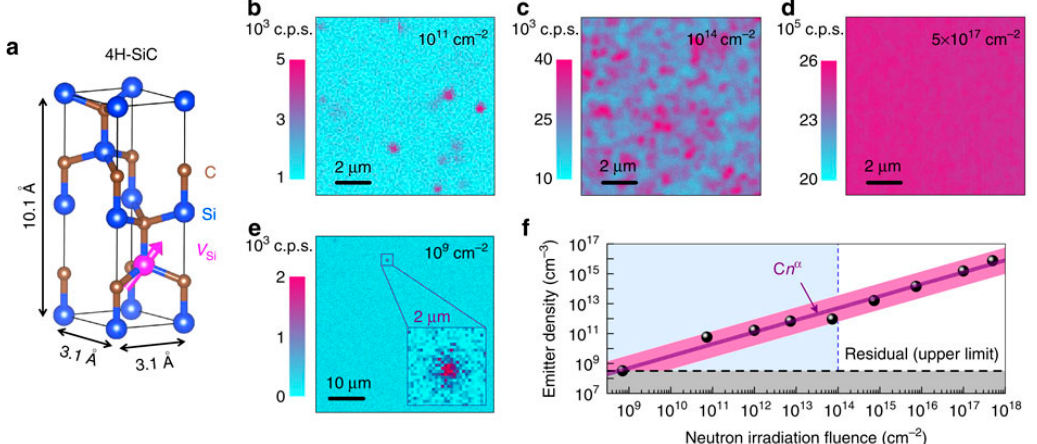
Figure 3. ( a ) scheme of the 4H-SiC with the single VSi defect; ( b – d ) confocal microscopy scans 10 × 10 μ m 2 for different neutron irradiation doses respectively n = 1 × 10 11 cm − 2 , n = 1 × 10 14 cm − 2 and n = 5 × 10 17 cm − 2 ; ( e ) confocal microscopy scan 50 × 50 μ m 2 for n = 1 × 10 9 cm − 2 ; ( f ) concentration of single photon emitters vs. the irradiation dose. Reprinted by permission from Reference [22], copyright 2015, Macmillan Publishers Ltd.: Nature Communications.